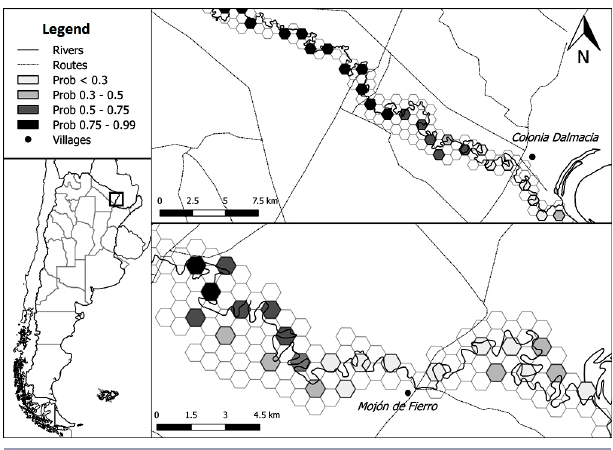
Fig. 3 . Modeled relationship between (A) village distance, (B) forest cover, (C) fruit trees presence, (D) river length and the probability of site occupancy by Bared-face Curassow in the Humid Chaco, northern Argentina. Dotted lines indicate 95% confidence intervals.